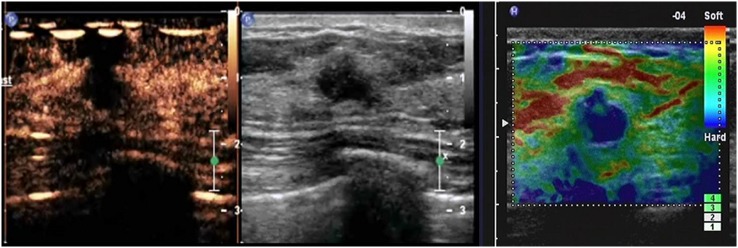
A lesion was categorized as BIRADS 4B, with a score of 4 by elastography, and with a score of 1 by CEUS 5-point scoring system.The pathological result of the lesion was fibrocystic mastopathy with cyst formation.